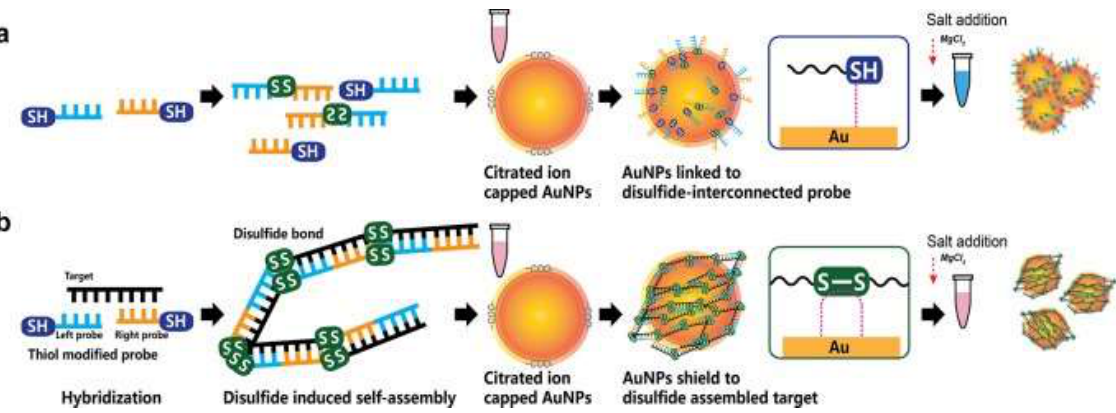
Figure 3. Disulfide bond-based colorimetric assay developed by Kim et al. for MERS-CoV detection. The color change is determined by whether the gene target is absent ( a ) or present ( b ). Repurposed from [80].